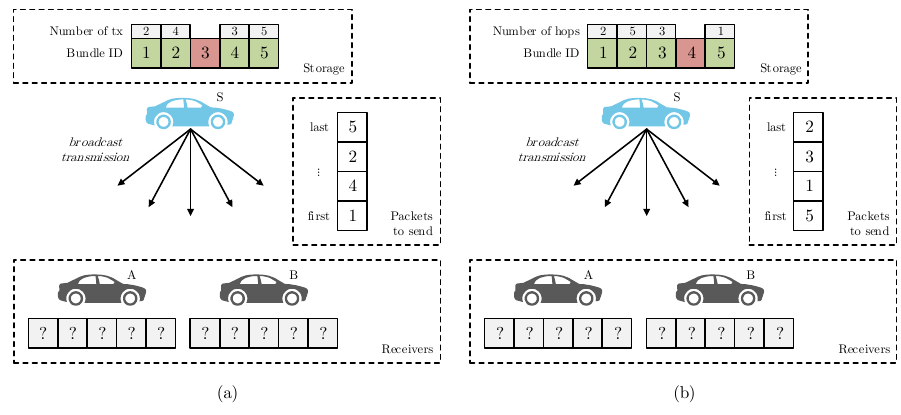
Figure 2. Forwarding decision of LNHF strategy in a ( a ) RSU and ( b ) an OBU—example.